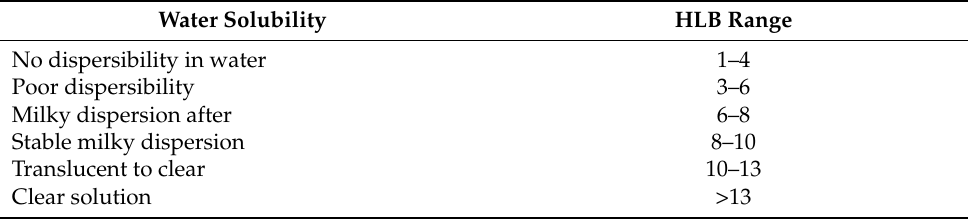
Table 3. Water solubility and hydrophilic/lipophilic balance (HLB). Water